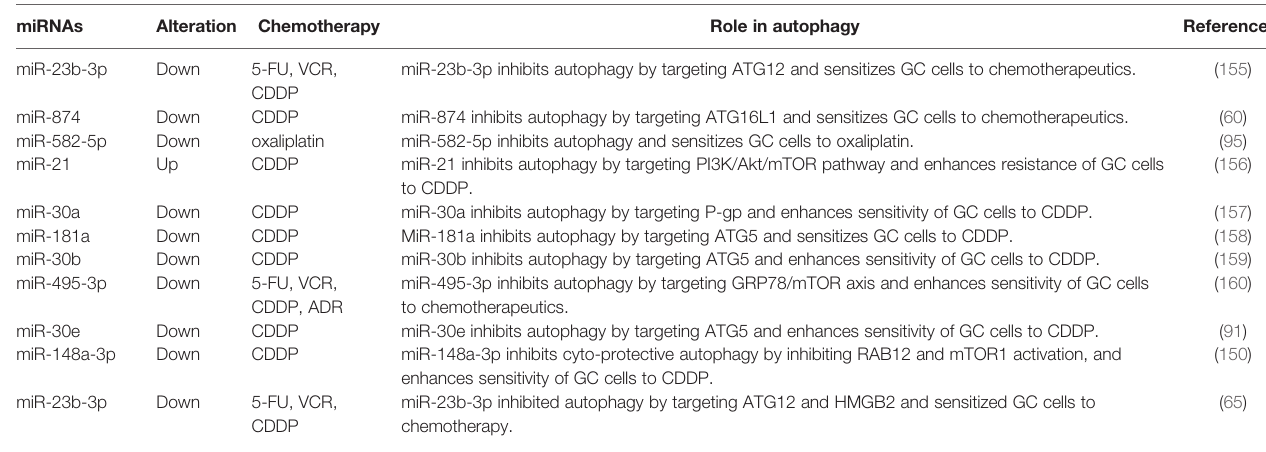
TABLE 2 | Regulation of miRNA on autophagy in GC drug resistance. miRNAs Alteration